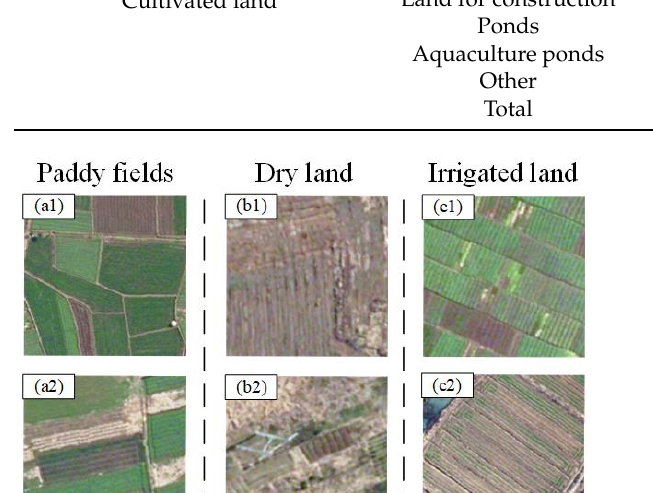
Table 2. The situation of land types corresponding to the cultivated land patches in the second and third national land surveys.